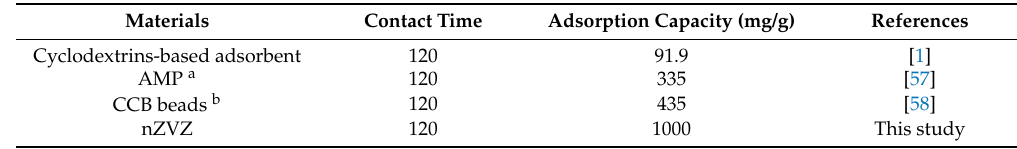
Table 8. Adsorption capacity of MG for different adsorbents.